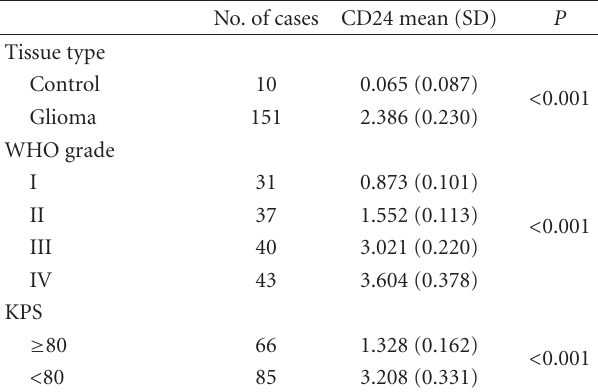
Table 2: Statistics of CD24 mRNA levels in